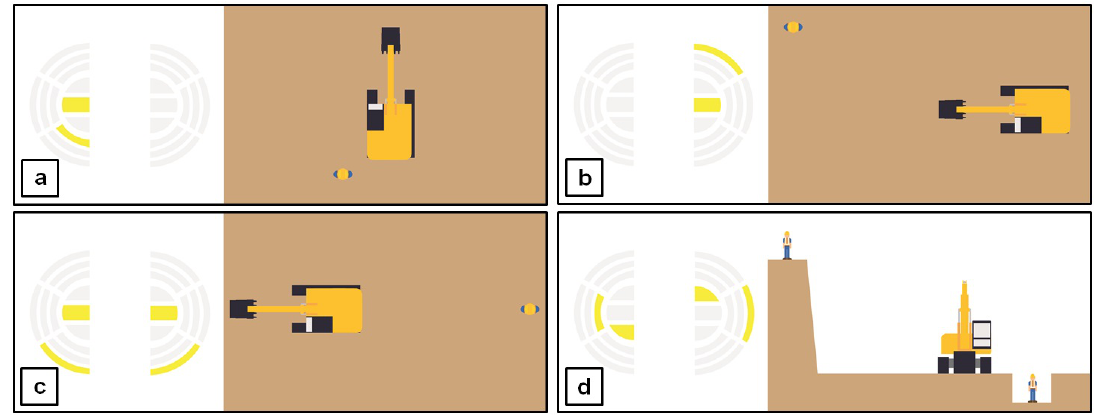
Figure 5. The left image illustrates how the obstacle’s position with respect to the excavator is determined whether it is on the left side or the right side of the machine, while the distance between the excavator and the obstacle is divided into three categories: near (1 radius of the machine), medium (2 radii), and far (3 radii). The right image indicates the meaning for each segment in the proximity warning concept.